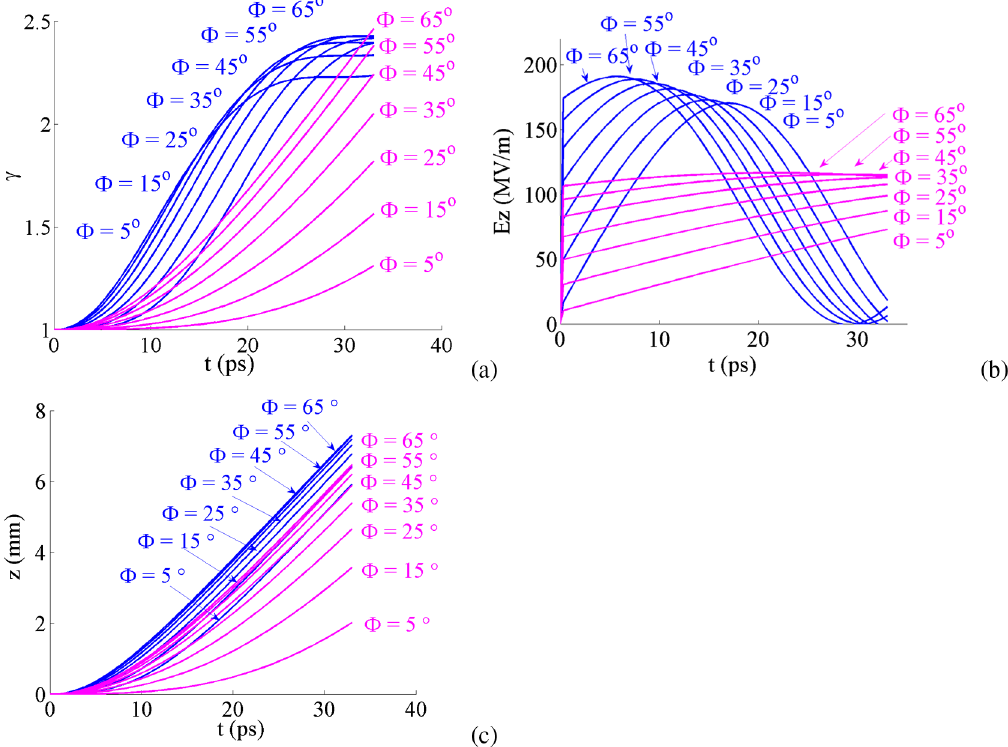
FIG. 6. (a) Evolution of γ with time for a single electron in a 200 MV = m X-band gun (blue) and a 120 MV = m S-band gun (magenta) for different initial rf phases, (b) corresponding longitudinal electric field seen by the electron and (c) distance from cathode as a function of